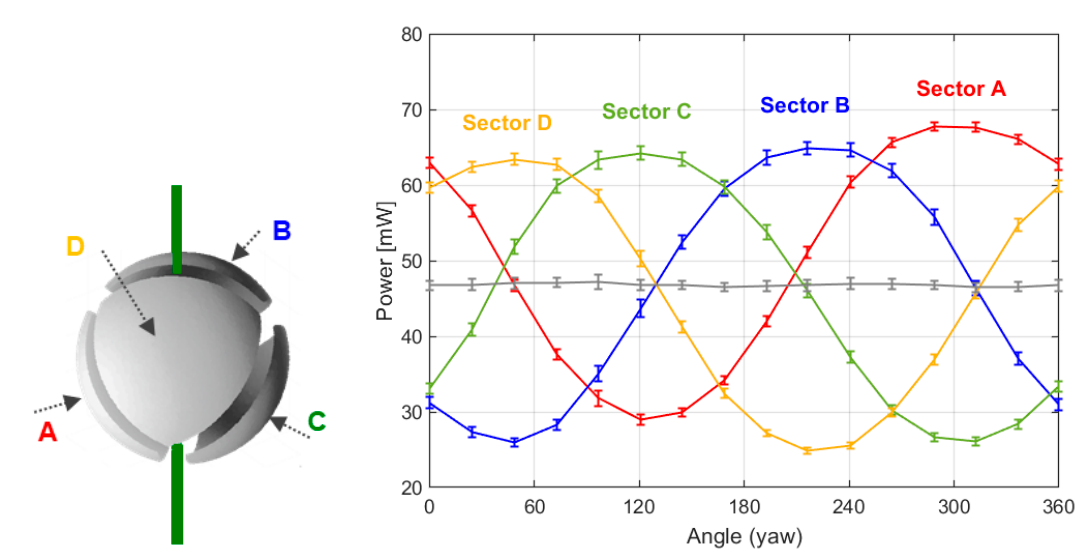
Figure 11. ( Left ) Diagram showing the di ff erent sectors names in the sphere. ( Right ) Power delivered to all Pt resistors of the sensor (sectors A, B, C, D) in an experiment in which 0–360 ◦ yaw angles were swept for pitch angle = 0, at constant wind speed of 5.6 m / s. Steps of 22.5 ◦ in Carbon Dioxide atmosphere. P = 10.3 mbar, U = 5.6 m / s, T = − 1 ◦ C, Thot = 48 ◦ C. The grey line is the average power of the sectors. The 1 σ error bars of the measurements are also